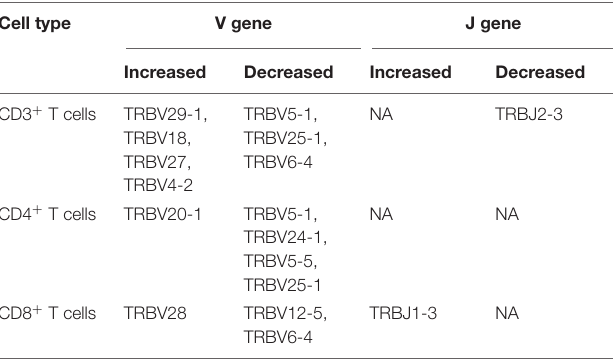
TABLE 1 | Differential expression of TRB V and J genes in T cells between TPE and paired